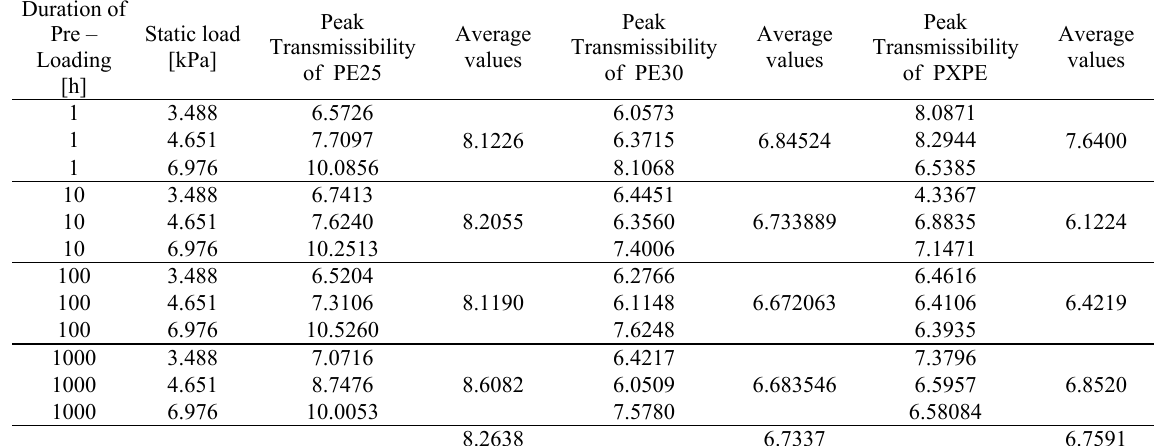
Table 2. Effect of the duration of pre-loading to the transmissibility Duration of Pre – Loading